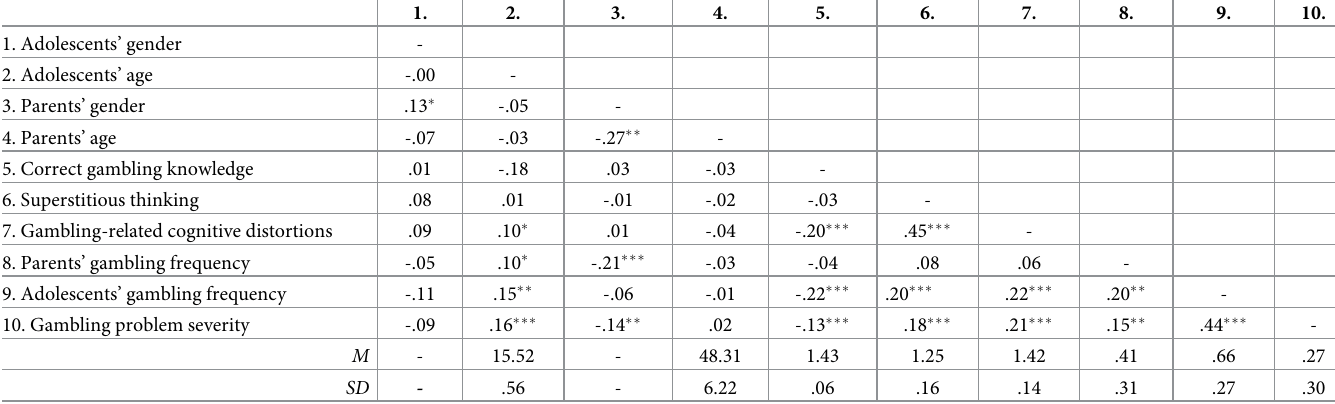
Table 2. Summary of intercorrelations, means and standard deviations of adolescents’ gender and age, parents’ gender and age, adolescents’ individual risk and protective factors, parental gambling frequency, and adolescents’ gambling behavior.